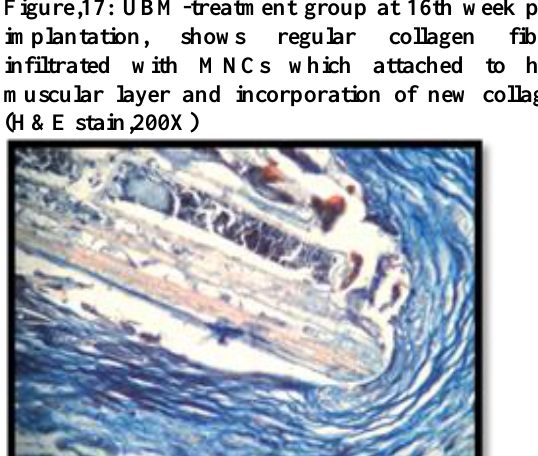
Figure, 18: UBM-treatment group at 16th week post implantation, shows the remnant of implant (long arrow) near the suture material surrounded by new fibrous tissue (Mallory stain,